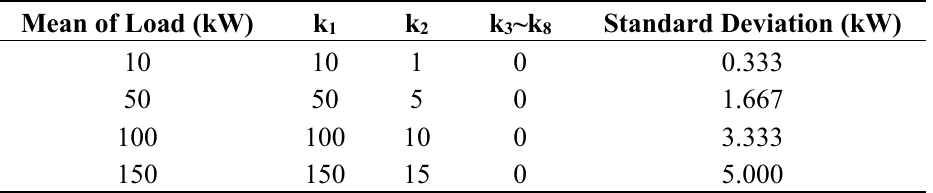
Table 1. Cumulants of parts of load